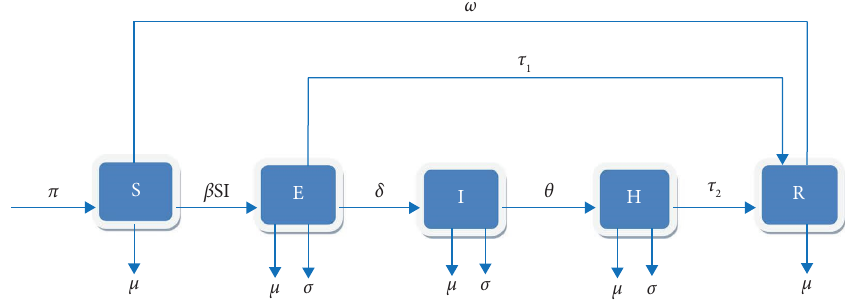
Figure 1: Flow diagram of COVID-19 transmission